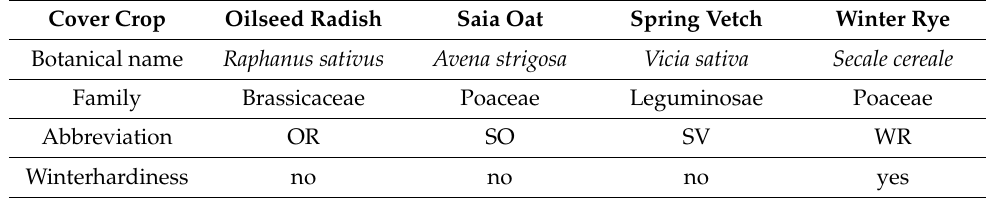
Table 1. Winter cover crops investigated in this study.